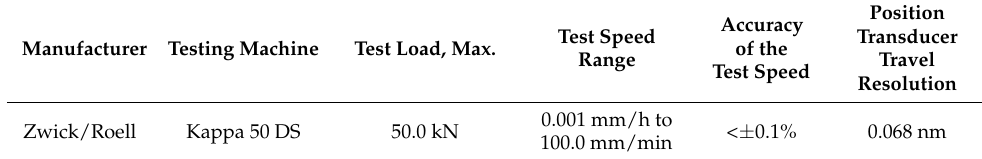
Table 3. Parameters of Zwick Roell Kappa.